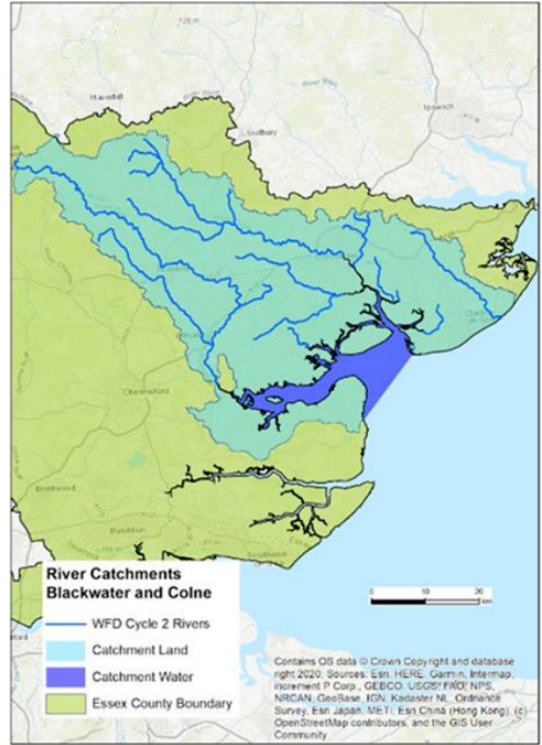
Figure 3. The proposed CFA for Essex. The chosen areas comprise the Colne and Blackwater catchments and together make up 30% of the county (ECA Commission, 2021). Source: Spains Hall Estate